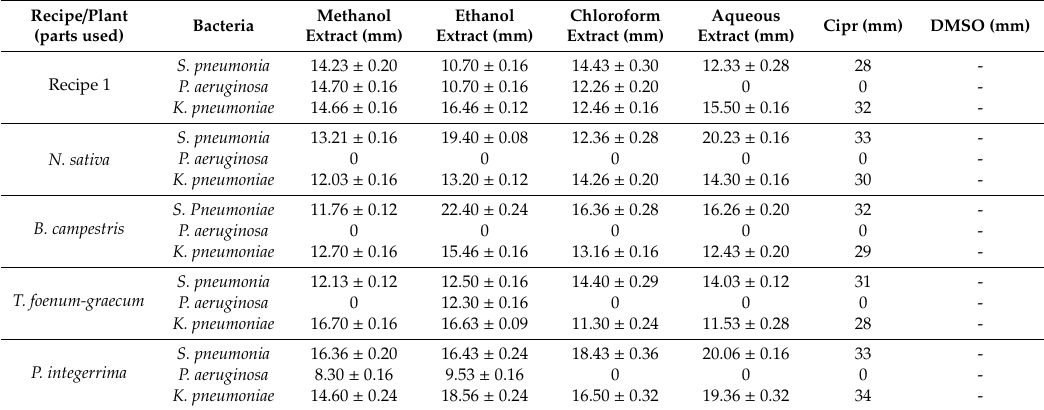
Table 2. Antibacterial activity of Recipe 1 and its individual plant extracts against three bacterial pathogens.